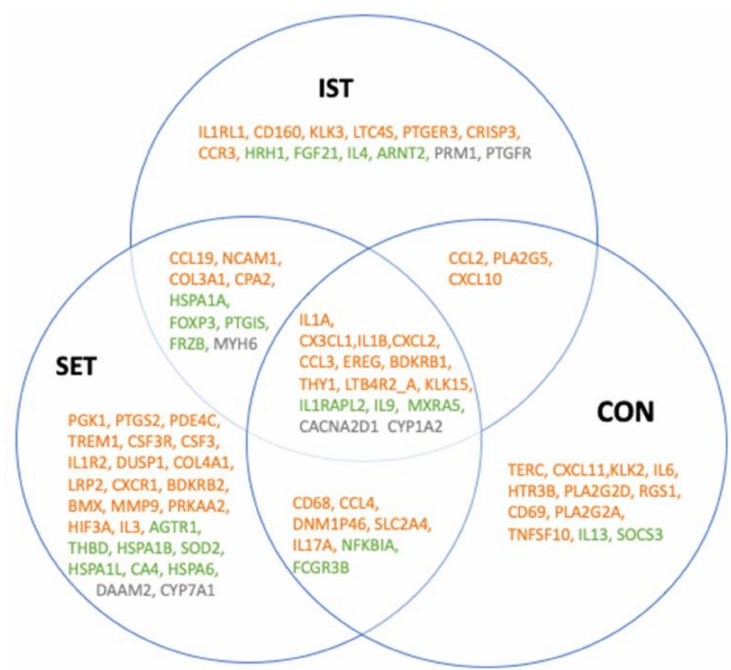
Figure 2. Venn diagram showing the overlap between groups of the 98 genes that were expressed significantly after the intervention. Orange: pro-inflammatory genes. Green: anti-inflammatory genes. Grey: genes where the role in inflammation has not yet been fully determined. Full gene abbreviations list for the can be found in Figures